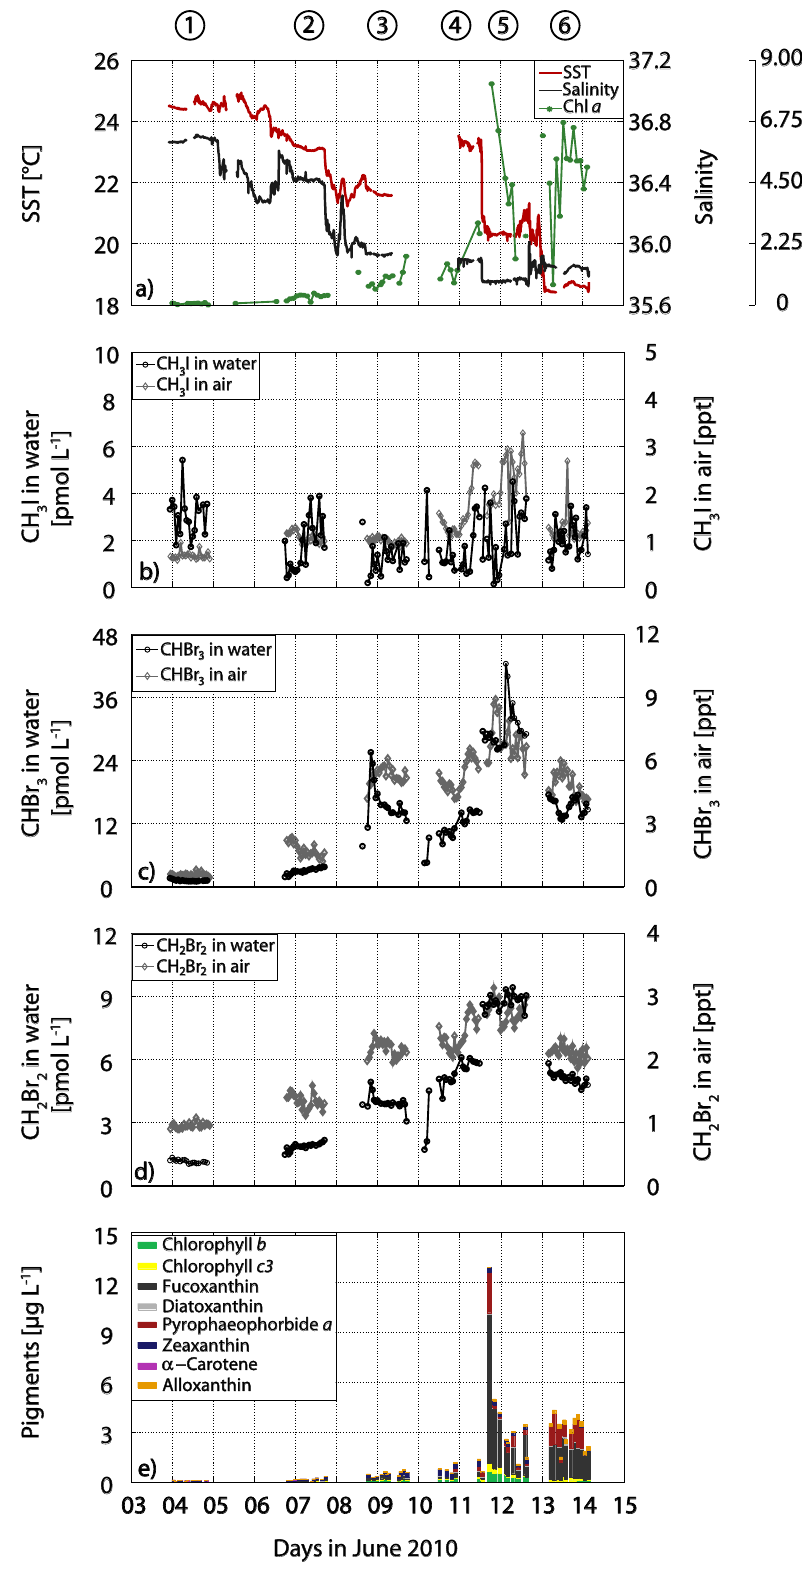
Fig. 2. SST, salinity and Chl a (a) along with halocarbon concentrations in water and atmospheric mixing ratios of CH 3 I (b) , CHBr 3 (c) and CH 2 Br 2 (d) and pigments significant for the regional distribution of CHBr 3 and CH 2 Br 2 (e) during the DRIVE campaign.